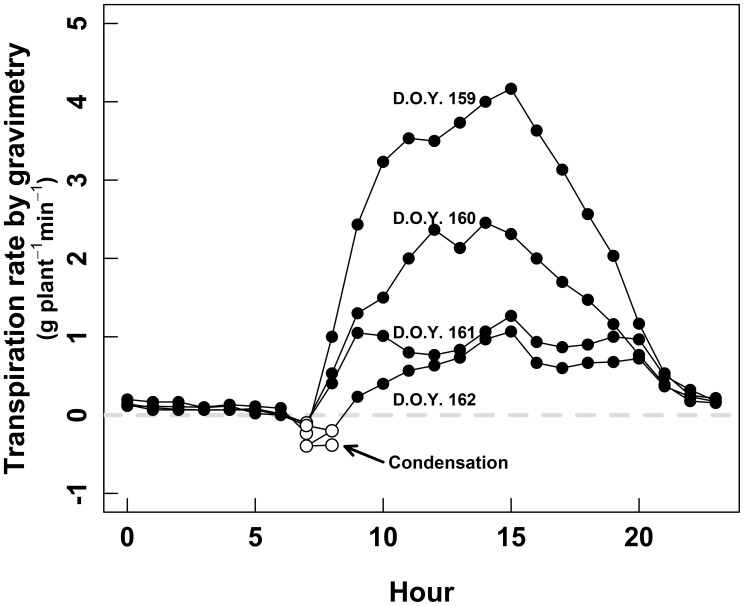
Daily course of the whole-plant transpiration measured by gravimetry during the second calibration session (D.O.Y. 158 to D.O.Y. 162). The black dots denote positive transpiration, while the white dots denote negative transpiration, interpreted as condensation during the earlier hours of the day.